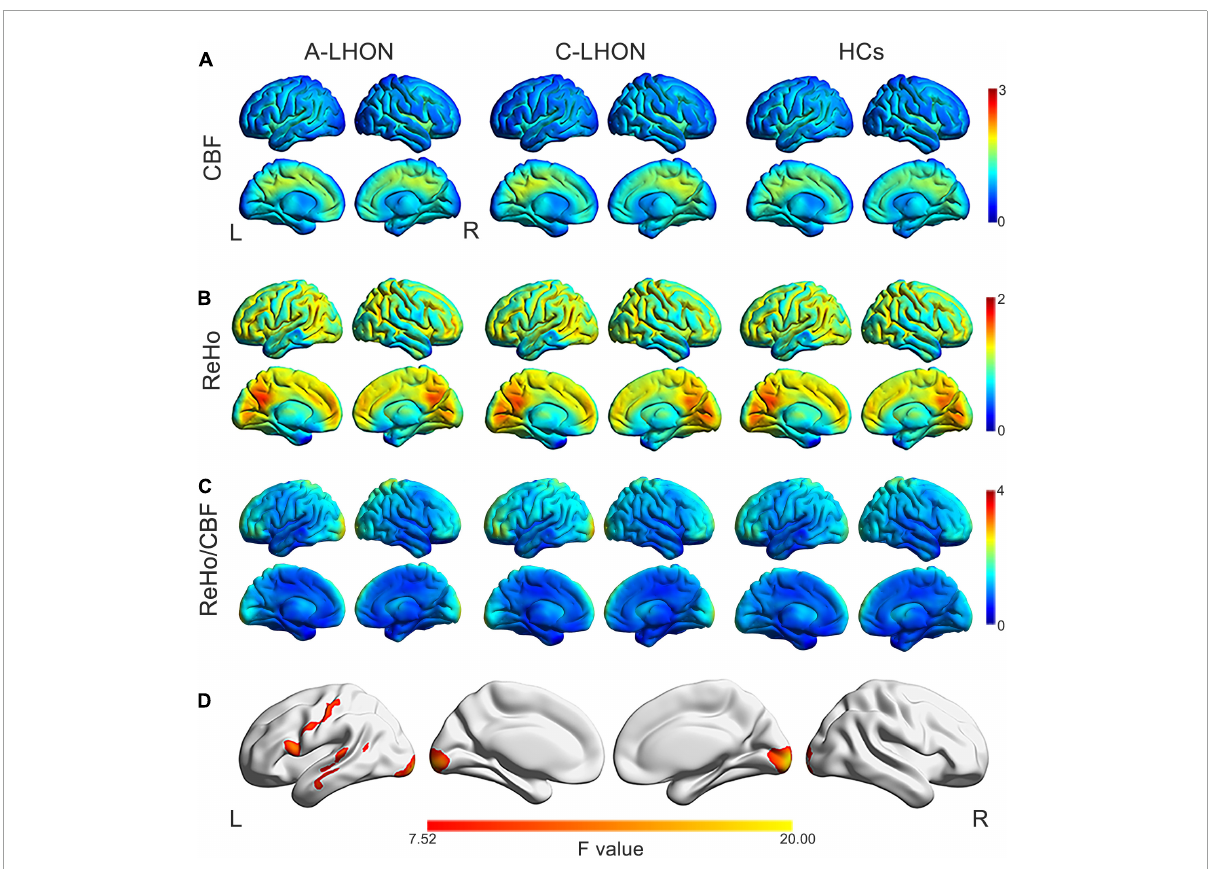
FIGURE1 ReHo, CBF, and ReHo/CBF ratio maps and intergroup differences in ReHo/CBF ratio. Average CBF (A) , ReHo (B) , and ReHo/CBF ratio (C) maps are present for A-LHON (left), C-LHON patients (middle), and HCs (right). (D) Represents one-way analysis of variance for intergroup differences in ReHo/CBF ratio between the three groups ( p < 1.00e - 3 , family wise error corrected at the cluster level). CBF, cerebral blood flow; ReHo, regional homogeneity; A-LHON, acute Leber’s hereditary optic neuropathy; C-LHON, chronic Leber’s hereditary optic neuropathy; HCs, healthy